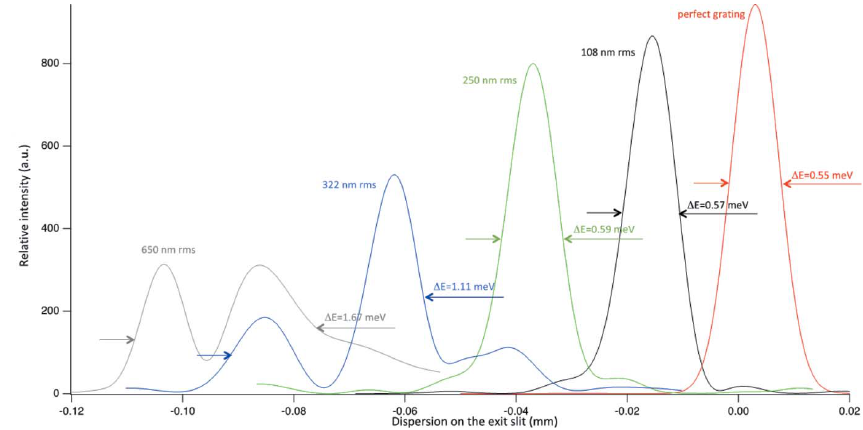
Figure 8 Results of wavefront propagation for the LEG at 30 eV for various r.m.s. groove-placing errors. Each curve is reported with its FWHM in meVand with the associated r.m.s. groove placing error. Line colors match text colors.